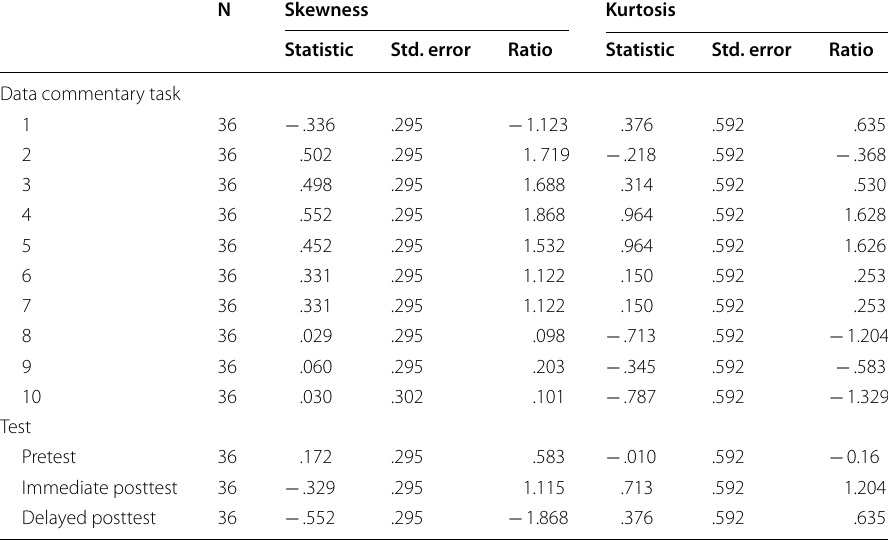
Table 2 Testing normality assumption N Skewness Kurtosis Statistic Std. error Ratio Statistic Std. error